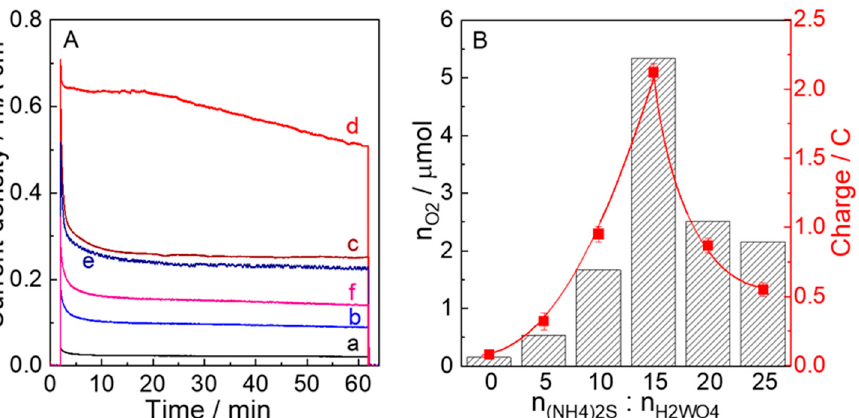
Figure 8. ( A ) Photocurrent density versus time profiles during PEC water oxidation in a 0.1 m phosphate buffer solution of pH 6.0 at 0.68 V vs. Ag/AgCl (1.23 V vs. RHE) and ( B ) O 2 evolution amounts (n O2 ) and charge amounts during the 1 h photoelectrocatalysis upon visible-light irradiation ( λ > 450 nm, 100 mWcm − 2 ) using (a) WO 3 − 0, (b) WO 3 − 5, (c) WO 3 − 10, (d) WO 3 − 15, (e) WO 3 − 20, and (f) WO 3 − 25